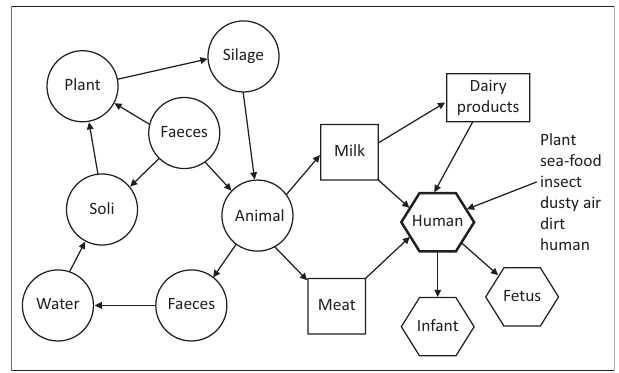
FIGURE 3: Implicated routes of transmission for Listeria monocytogenes infection to